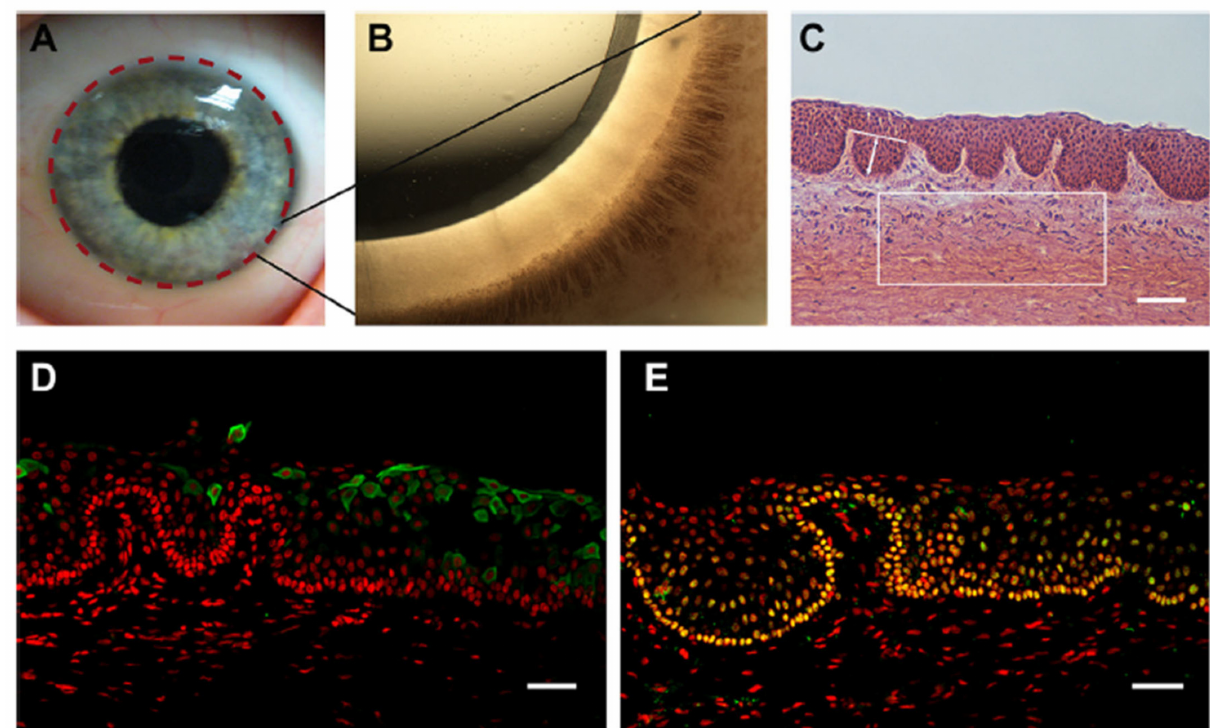
Figure 3. The human limbal stem cell niche. ( A ) Describes the location of the limbus with dashed lines on the human ocular surface. ( B ) Shows a highly pigmented Palisades of Vogt that is visible in the limbus of human. ( C ) Indicates H and E-stained tangential section of the human limbus, showing the LCs (limbal crypts). The box indicates a representative area of 0.1 mm 2 of the limbal stroma. The white line indicates an example of LC width measurements and arrowed line LC depth measurements. ( D ) CK3- and ( E ) p63a (green)-stained cryosections of human LCs counterstained with PI (red). Scale bars C: 100 µ m, D and E: 50 µ m